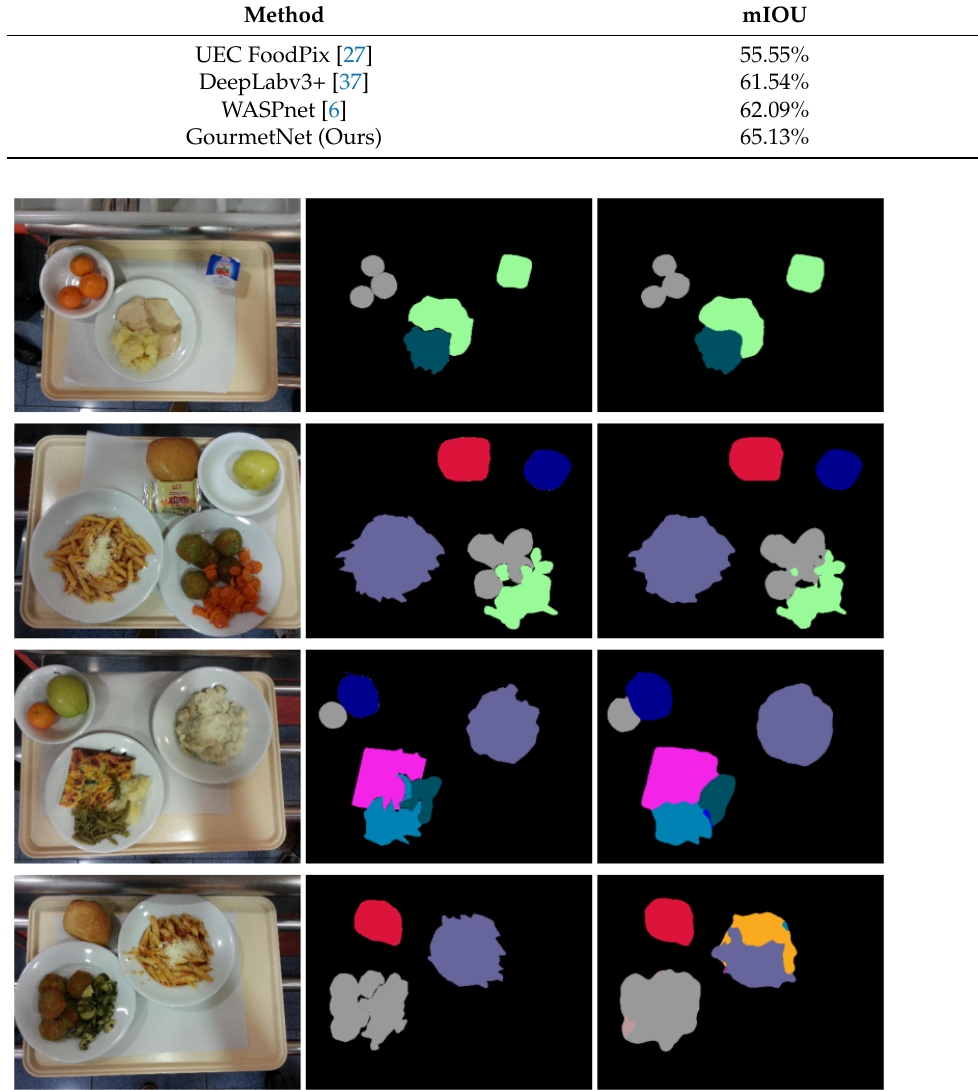
Table 4. GourmetNet results and comparison with SOTA methods for the UEC FoodPix dataset.